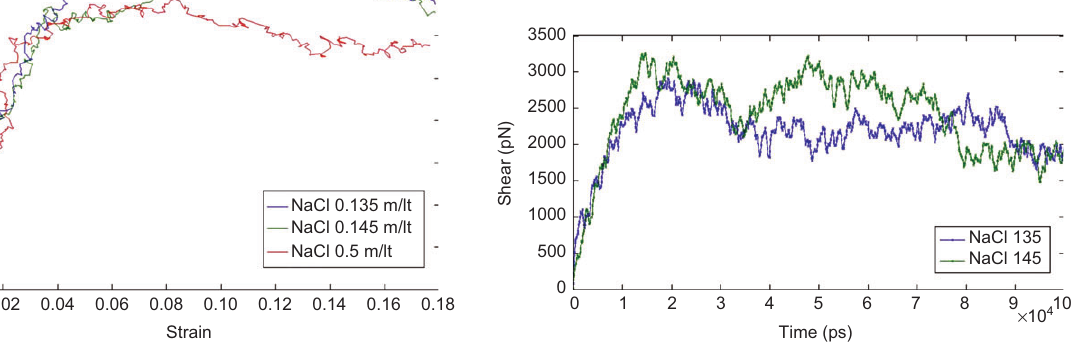
Figure 8 Shear strength vs. time for tropocollagen with 135 and 145 meq/l NaCl.